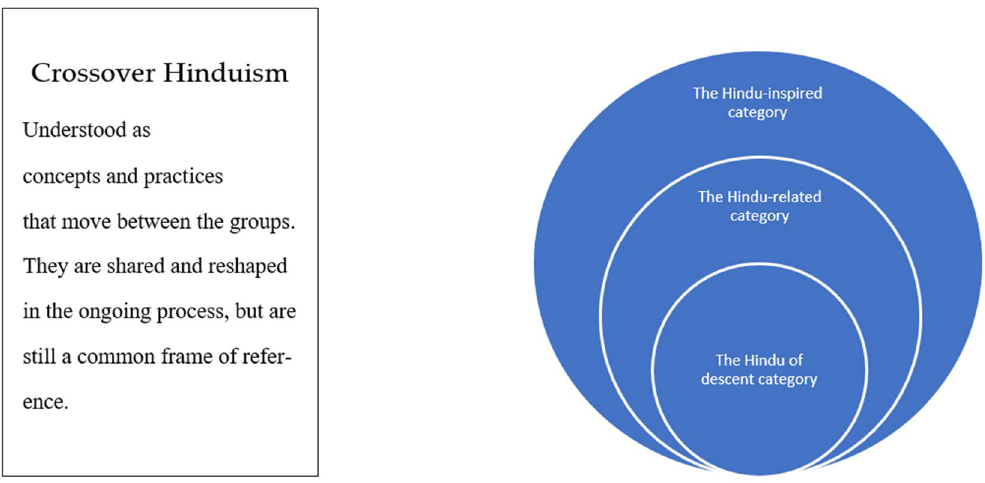
Figure 1. Suggested categories or typologies of Hinduism in Denmark.